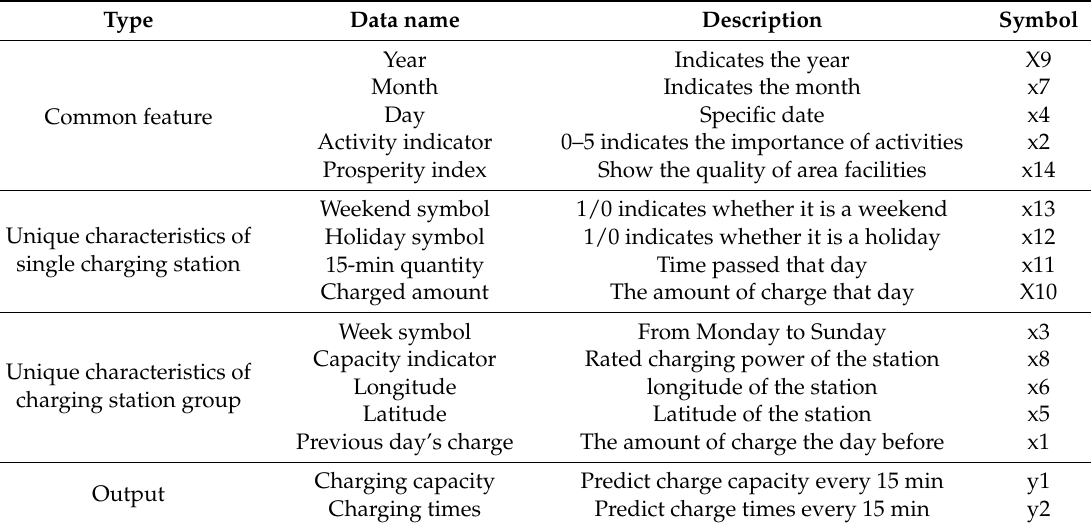
Table 1. Input and output table for